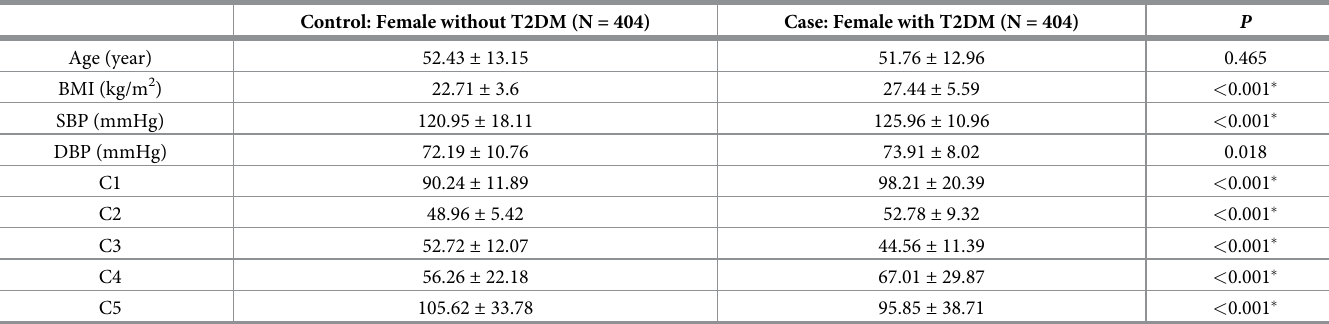
Table 1. T-test for characteristics of the case and control populations.